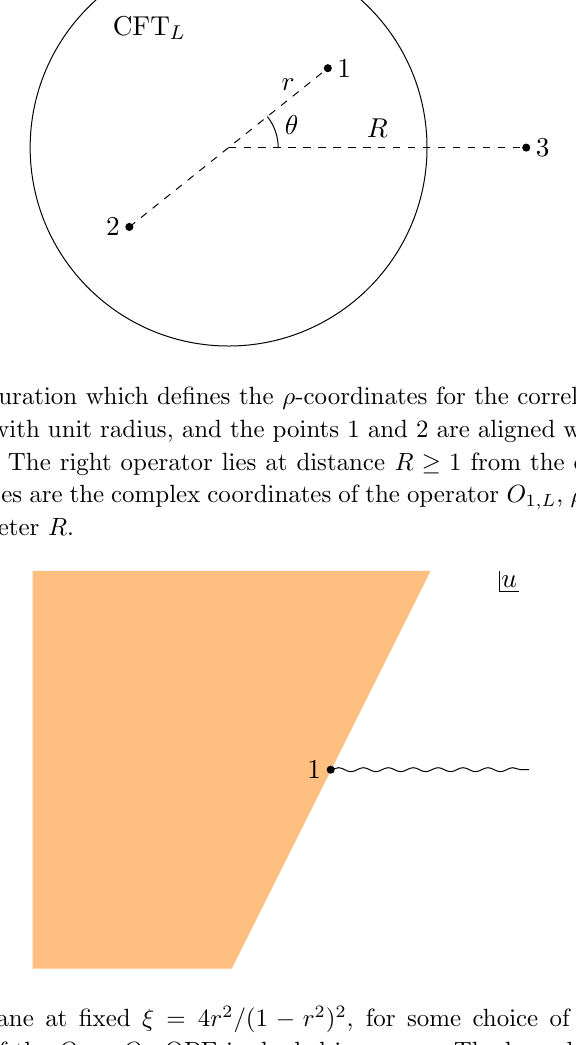
Figure 15 . The u plane at (cid:12)xed (cid:24) = 4 r 2 = (1 (cid:0) r 2 ) 2 , for some choice of r with j r j < 1. The region of convergence of the O L (cid:2) O L OPE is shaded in orange. The boundary is the straight line < u + (cid:11) I u (cid:0) 1 = 0 ; with (cid:11) = 2 I r 2 = (1 (cid:0) j r j 4